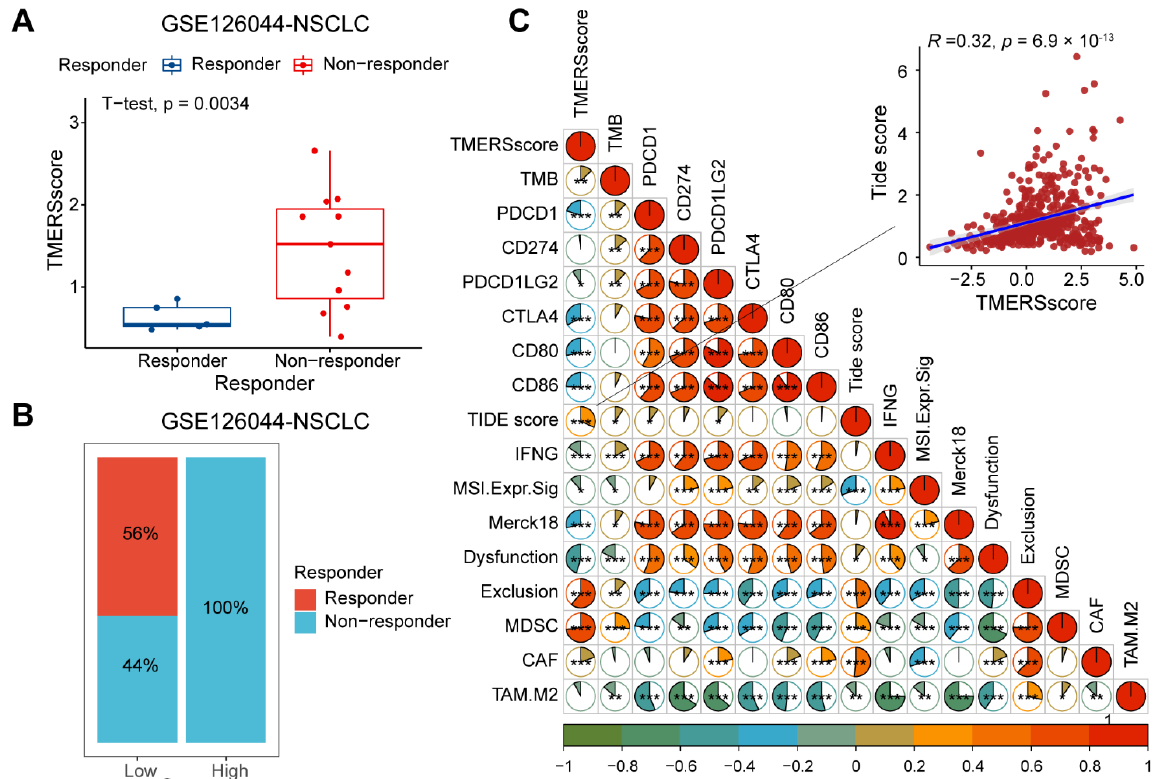
Figure 7. Evaluation of ICI therapeutic efficacy of LUAD patients by TMERSscore. ( A ) Boxplot demonstrating the difference in TMERSscore between responder and non-responder LUAD patients in the GSE126044 dataset receiving anti-PD-1 treatment. ( B ) Bar graph illustrating the percentage of clinical response to anti-PD-1 immunotherapy in the high and low TMERSscore groups for the GSE126044 dataset. ( C ) Correlations between TMERSscore values, TMB, PD-1, PD-L1, CTLA-4, CD80, CD86, TIDE score, IFNG, MSI.Expr.Sig, Merck18, Dysfunction, Exclusion, MDSC, CAF, TAM.M2 scores in the TCGA cohort. Different correlations between two signatures are indicated by different colors. * p < 0.05, ** p < 0.01, *** p < 0.001.